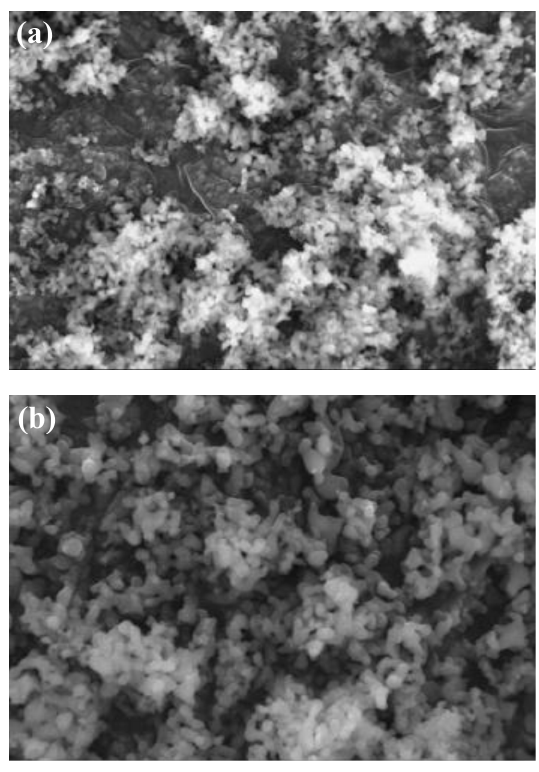
Figure 5. SEM result of impregnation.